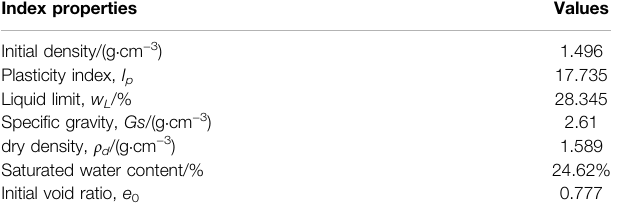
TABLE 1 | Basic physical parameters of soil sample.